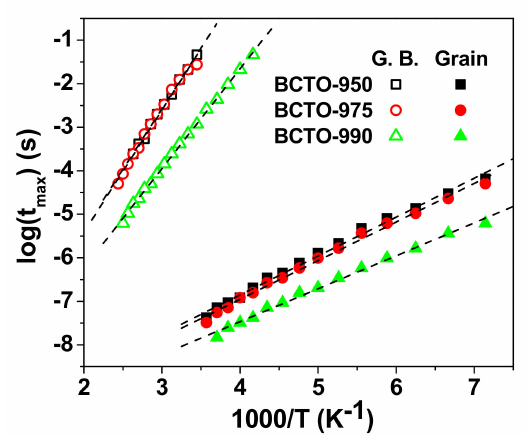
Figure 10. The Arrhenius plots of the relaxation time τ in grain and grain boundary for BCTO ceramics. The dashed line represents the line of best